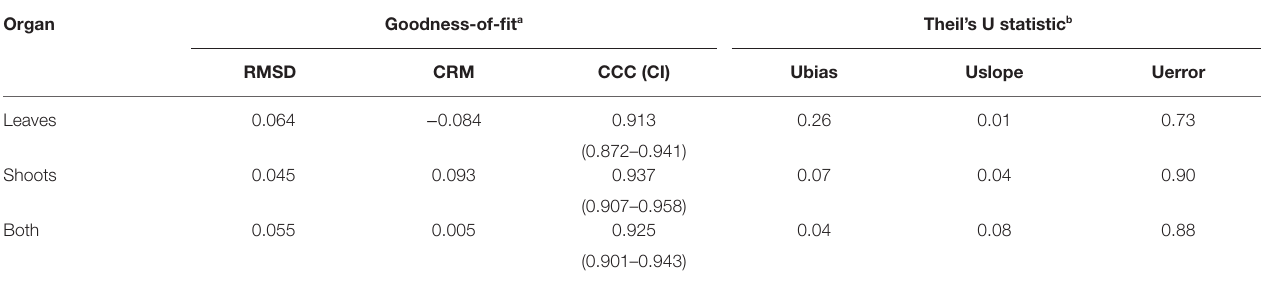
TABLE 3 | Overall goodness-of-fit and Theil’s U statistic for the PCLS infection (of leaves, shoots, and both leaves and shoots) predicted by the model and the disease incidence observed in the vineyards of Table 2 .